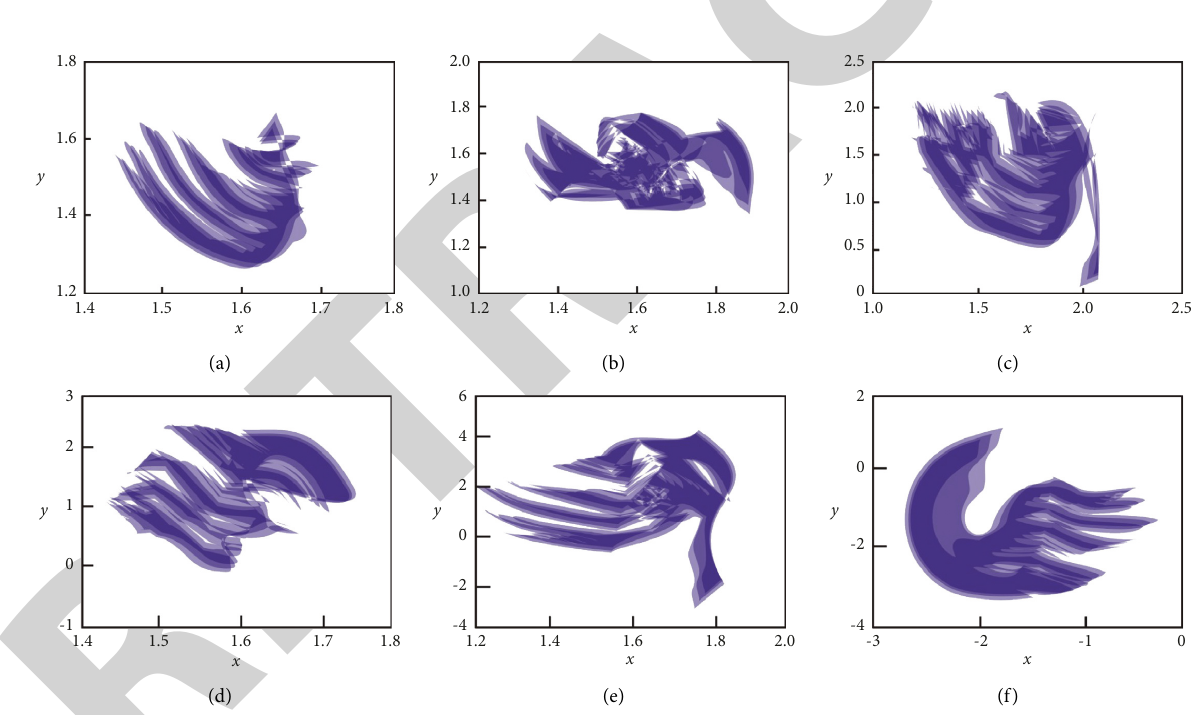
Figure 5: Phase diagram of the system changing with parameter c : (a) c � 0.07; (b) c � 0.117; (c) c � 0.25; (d) c � 0.51; (e) c � 0.532; (f) c �